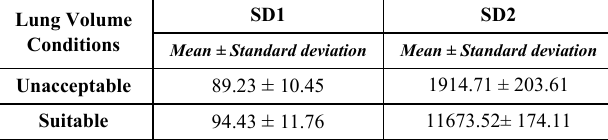
TABLE 1: The average and the standard deviation of the SD 1 and SD 2 parameters with τ = 1.